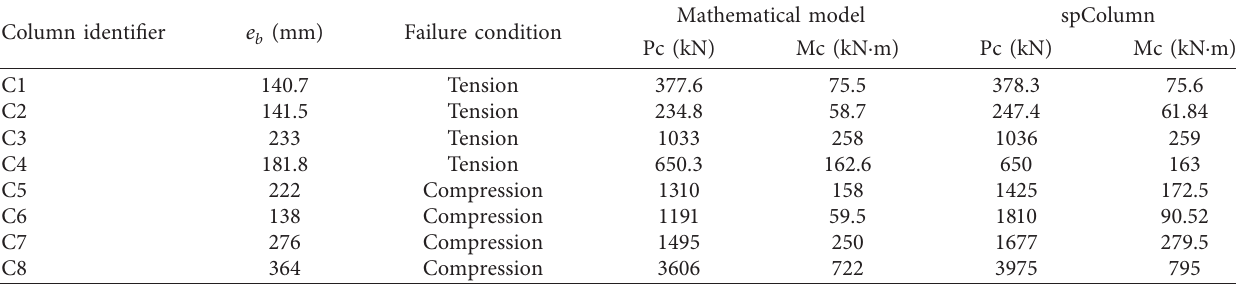
Table 2: Uniaxial column design results.